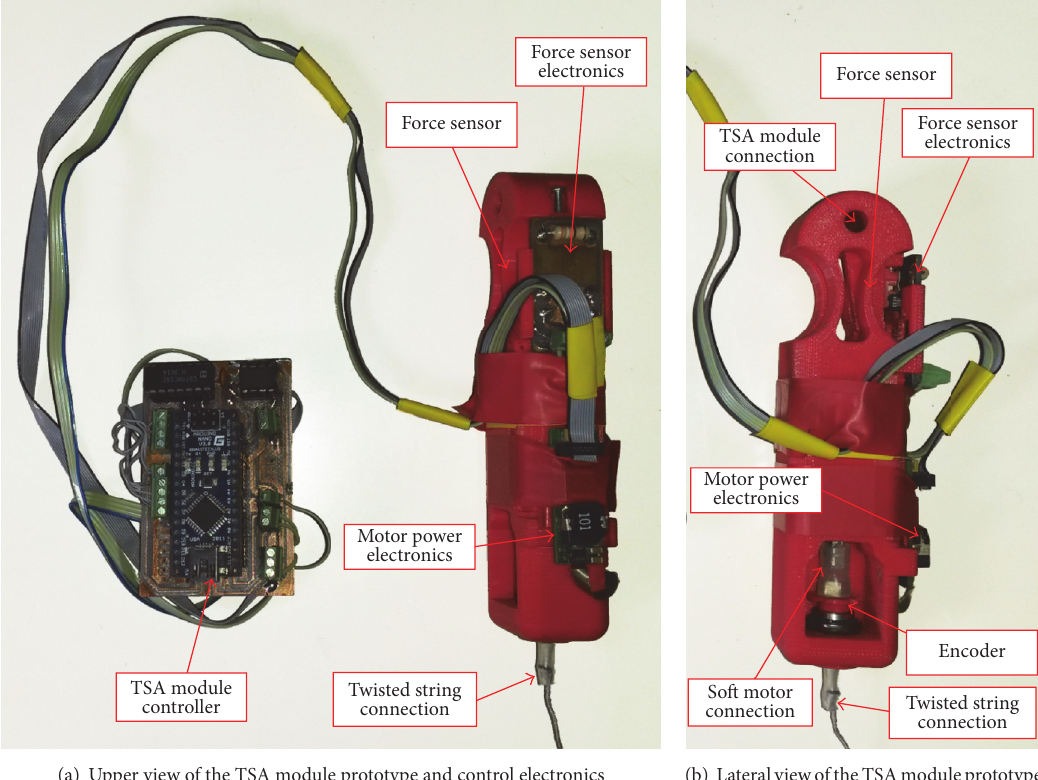
Figure 5: Detailed view of the TSA module prototype and control